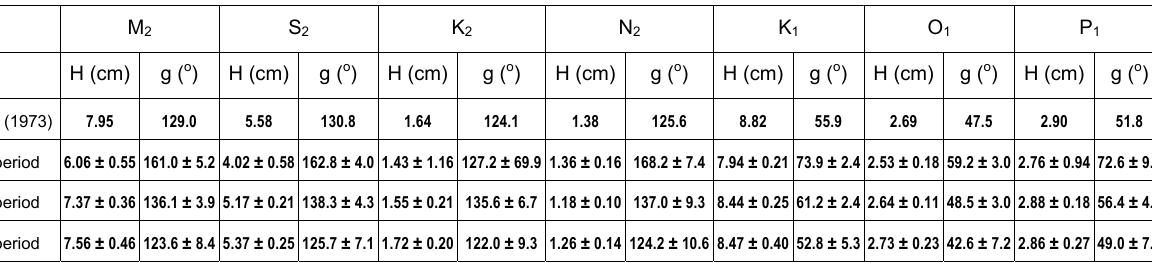
Table 1. Average amplitudes and phases, together with standard deviations calculated for T1, T2 and T3 periods. The constituents given by ˇSigud (1973) are shown, too. Table 1.